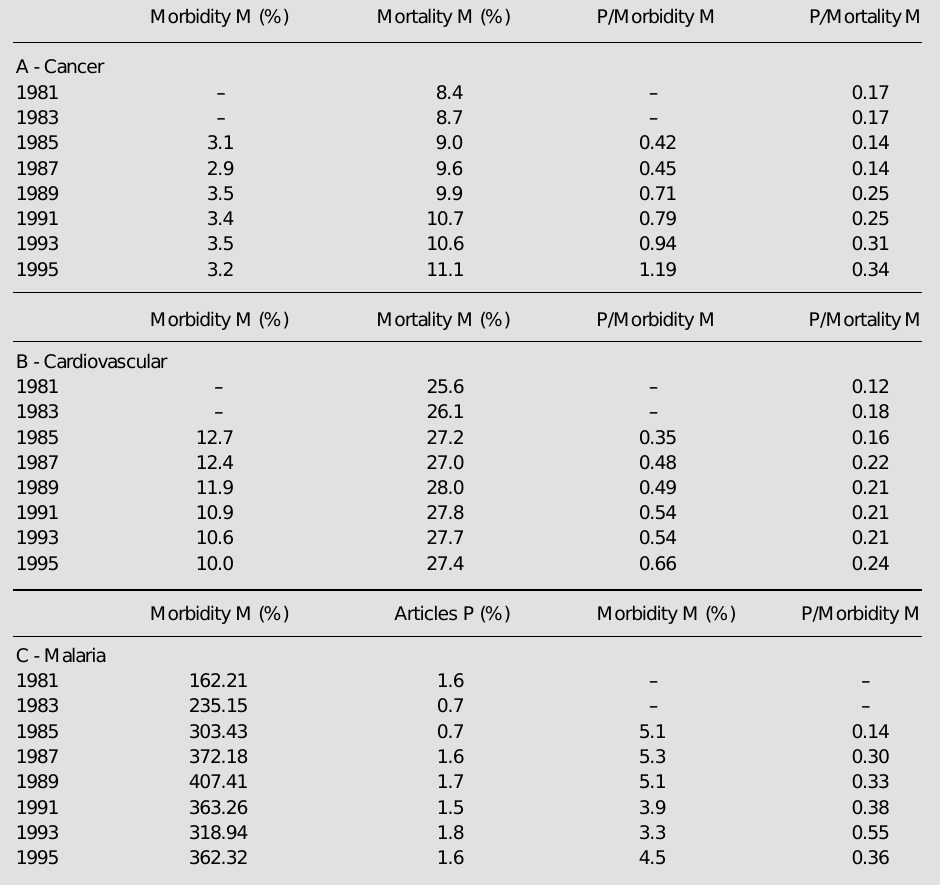
Table 3 - Morbidity and mortality numbers per 100,000 habitants were used as indicators of disease burden. Morbidity numbers for cancer and cardiovascular diseases were obtained from data about patient hospitaliza- tion, while morbidity numbers for malaria were obtained from positive blood testing for this disease. M: Represents morbidity/mortality for cancer, cardiovascular disease and malaria with the relative weight (%) of each disease within the total disease burden indices. P: Relative proportion (%) of article output in each area to the total number of articles in the life sciences. Cancer: The 1995 indices were 257.2 for morbidity and 63.6 for mortality. Cardiovascular: The 1995 indices were 808.9 for morbidity and 157.0 for mortality. Morbidity M (%) Mortality M (%) P/Morbidity M P / Mortality